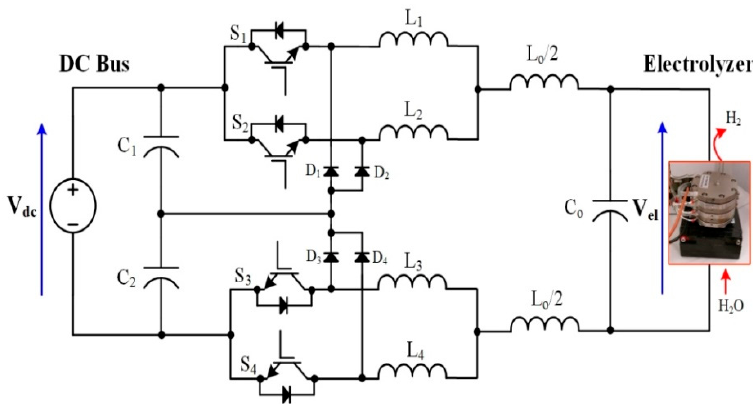
Figure 1. interleaved buck converter connected to a PEM EL.